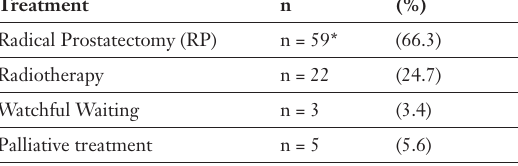
Treatment distribution of